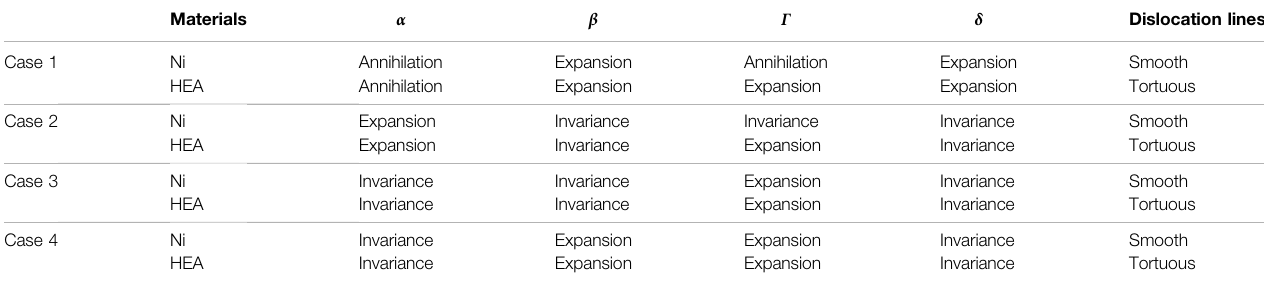
TABLE2| FinalstatesofSFTsandcharacteristicsofdislocationlinesinNiandCoCrFeNiMnHEAsamplesshearedindifferentdirections.Annihilationdenotingannihilationof SF; Expansion, formation and expansion of new SF; invariance, insigni fi cant changes in stacking faults.